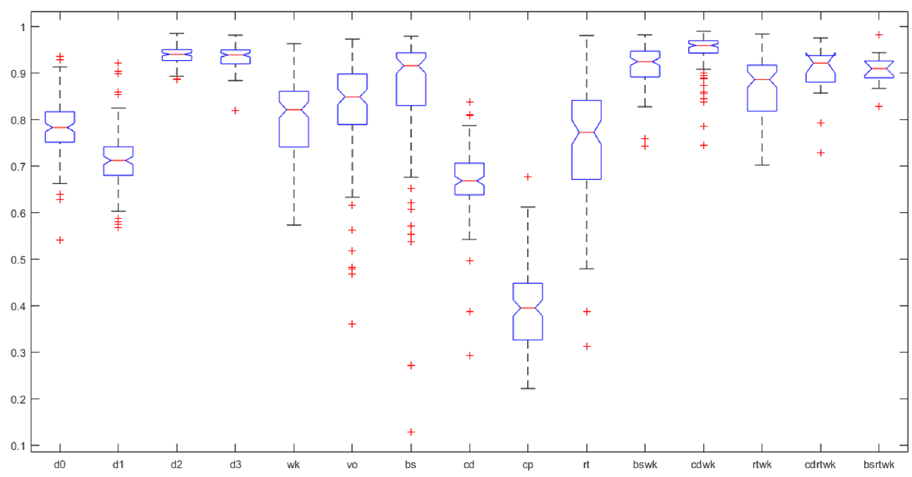
Fig. 6 Boxplot of R 2 -distribution of daily travel energy according the respective modes of transport. The abbreviations of the modes of transport are: d 0, d 1, d 2, d 3, as de fi ned above, wk — walking, vo — velo or bike, bs — stage bus, cd — car driver, cp — car passenger, rt — rail, and the respective combinations. HUMANITIES AND SOCIAL SCIENCES COMMUNICATIONS| (2021) 8:256